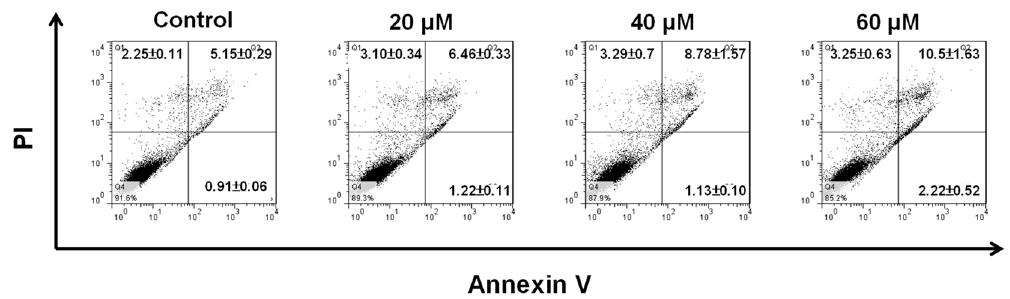
Figure 2. NOB induced apoptosis in BFTC bladder cancer cells. BFTC cells were treated with NOB at concentrations of 20, 40, and 60 μ M for 24 h, following which they were double-stained with fluorescein isothiocyanate (FITC) Annexin-V and propidium iodide (PI). The percentages of early and late apoptotic cells were analyzed by flow cytometry.